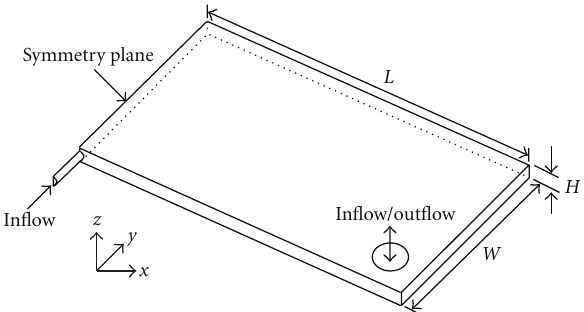
Figure 2: Schematic diagram of three-dimensional micro synthetic jet.